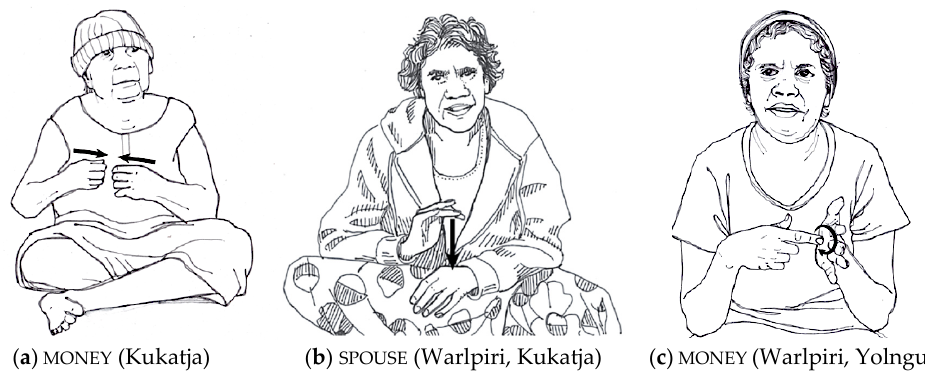
Figure 2. Examples of type 1, type 2, and type 3 two-handed signs ( a ) MONEY (Kukatja); ( b ) SPOUSE (Warlpiri, Kukatja); ( c ) MONEY (Warlpiri) (Illustrations: Jennifer Taylor).